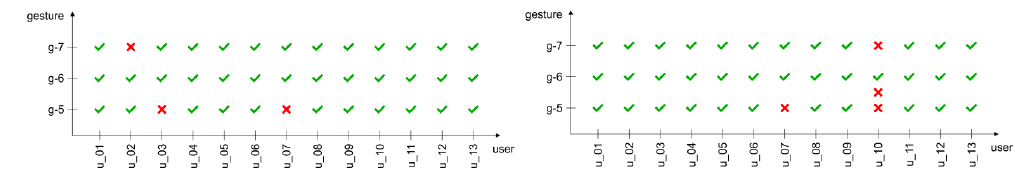
Figure 6. Detailed results for the S-2 scenario.